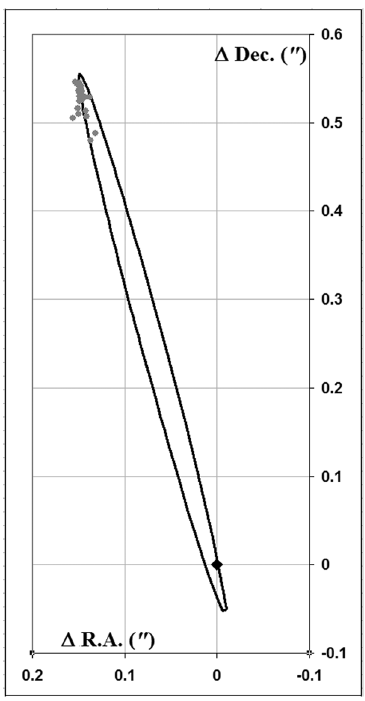
Figure 5: Orbit of S27.